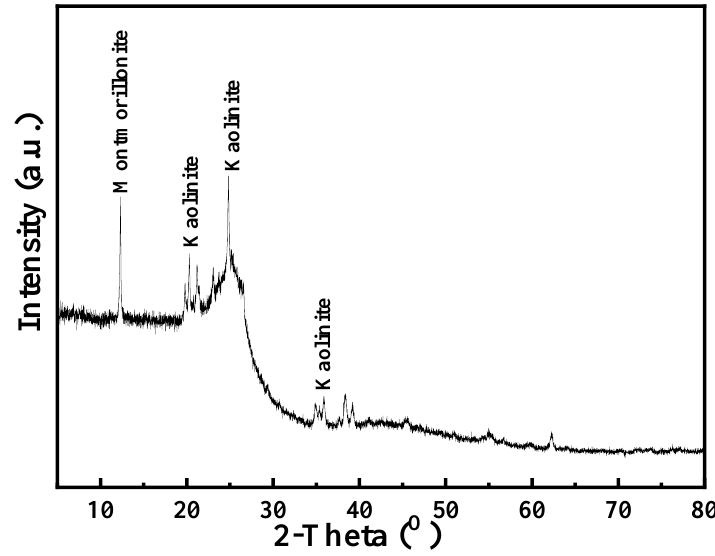
Figure 2. XRD analysis results of the coal samples.